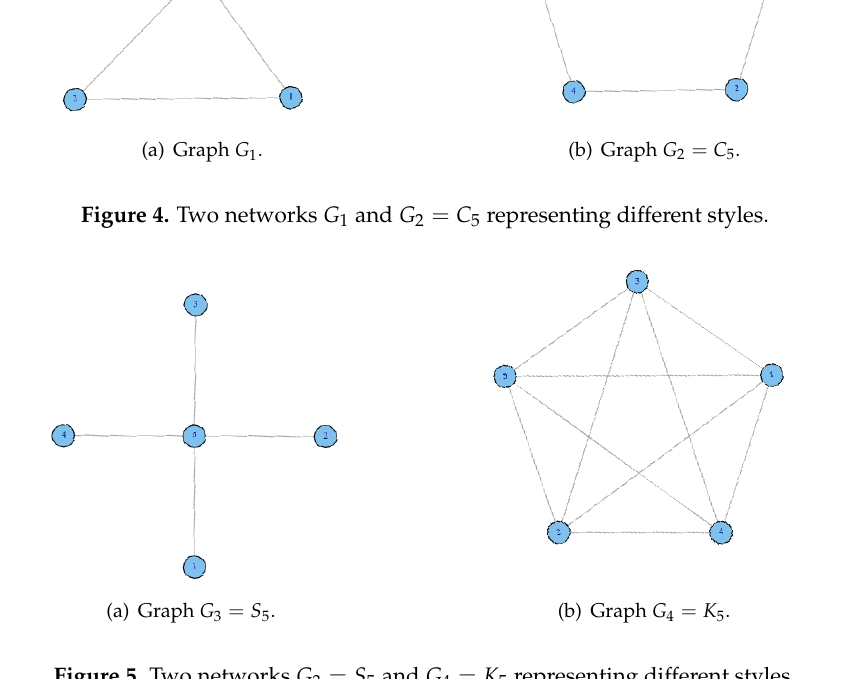
Figure 5. Two networks G 3 = S 5 and G 4 = K 5 representing different